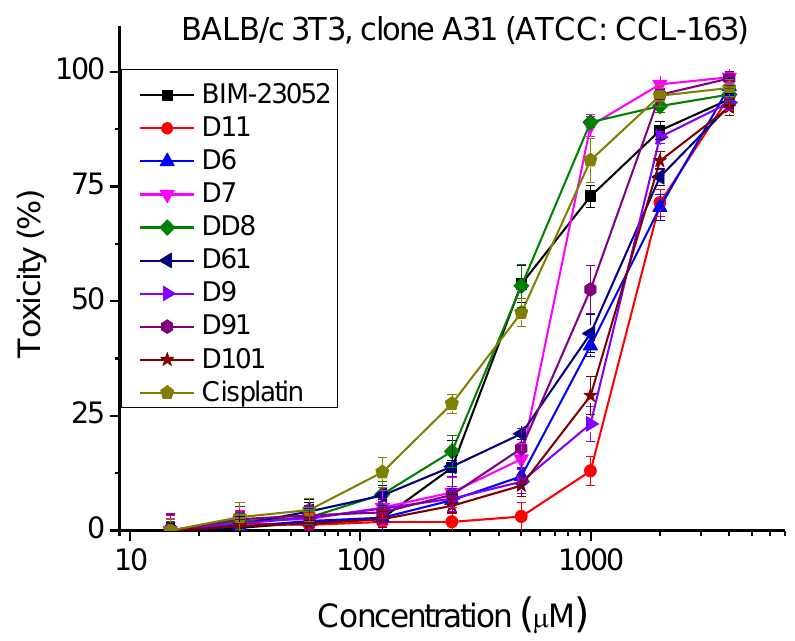
Figure 2. Dose–response curves for cytotoxicity of BIM-23052 analogs determined in mouse embry- onic fibroblasts (BALB/c 3T3 clone A31, ATCC ® CCL-163™). Mean values are presented ± SD from three independent experiments, n = 6.